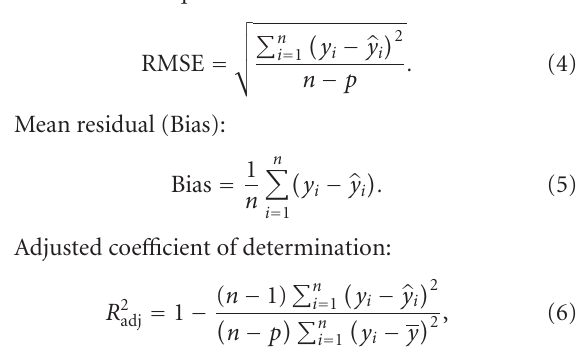
graphical analyses of the residuals. Also, four statistical criteria obtained from the residuals were examined: root mean square error (RMSE), mean residual (Bias), adjusted ), and Akaike’s information coe ffi cient of determination ( R 2 adj criterion di ff erences (AICd) [42]. The expressions of these statistics are summarized as